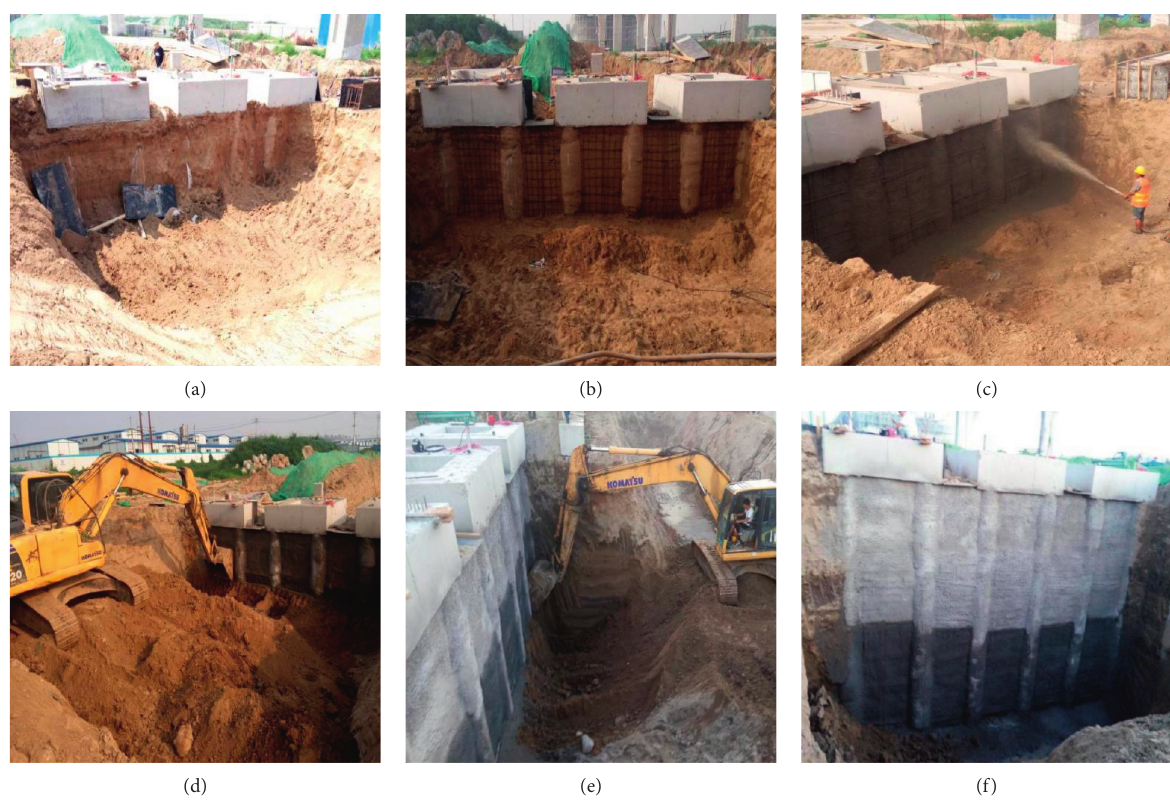
Figure 13: Excavation process of foundation pit. (a) Excavation of 2 m. (b) Hanging net between piles. (c) Spraying concrete. (d) Excavation of 4m. (e) Excavation of 6m. (f) Excavation of 8